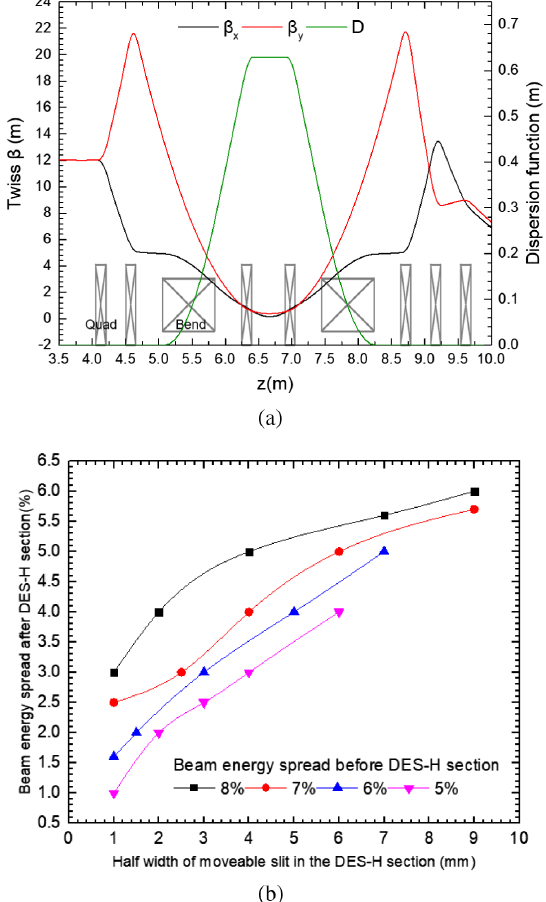
FIG. 3. Beam parameters in the DES-H section, showing (a) Twiss- β and dispersion functions along the z axis; and (b) Final energy spread against slit width for different initial energy spreads.